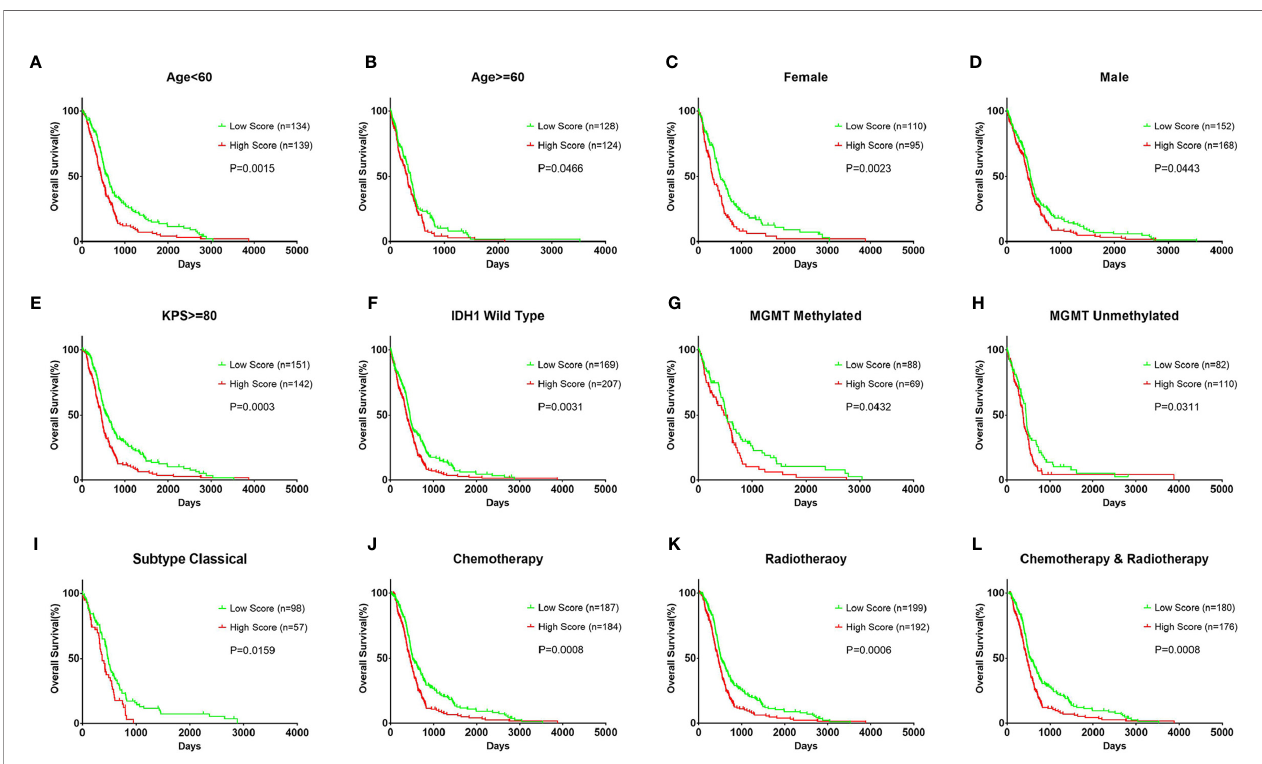
FIGURE 2 | Prognostic value of the risk score in different clinicopathological subgroups. (A, B) Kaplan – Meier survival analysis based on the median cutoff value of the risk score developed using the cluster 1 gene set in the training cohort in different age subgroups. (C, D) Kaplan – Meier survival analysis in different sex subgroups. (E) Kaplan – Meier survival analysis in KPS ≥ 80 patient subgroup. (F) Kaplan – Meier survival analysis in IDH1 wild-type patient subgroup. (G, H) Kaplan – Meier survival analysis in different MGMT methylation status subgroups. (I) Kaplan – Meier survival analysis in the classical subtype patient subgroup. (J – L) Kaplan –